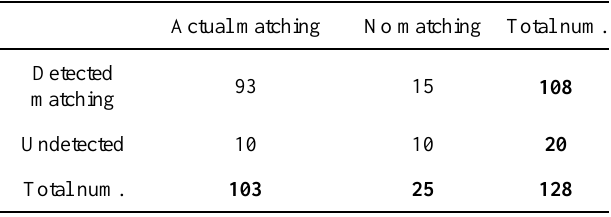
Table1. Statistical results of matching